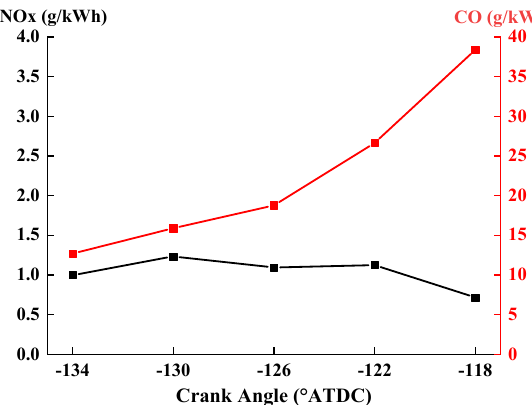
Figure 19. NOx and CO emissions with different IVC timings.